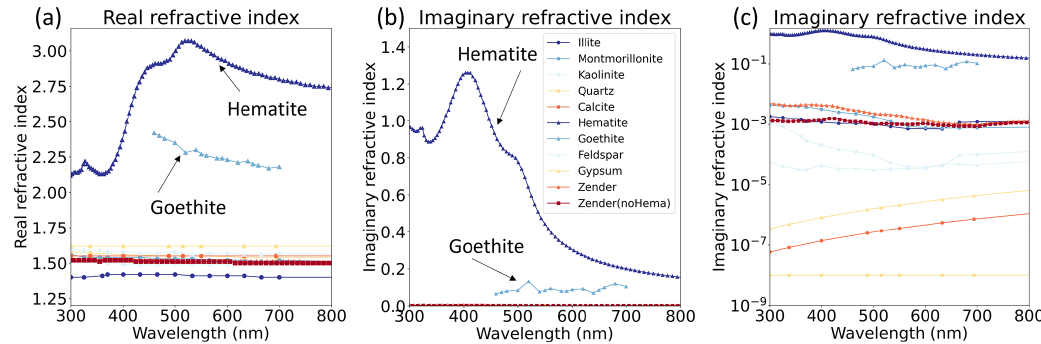
Figure 1. Complex refractive index based on soil mineralogy at 300–800nm (Scanza et al., 2015). Shown are the real refractive index (a) and the imaginary refractive index in linear (b) and log (c) scales. The goethite refractive index is from Bedidi and Cervelle